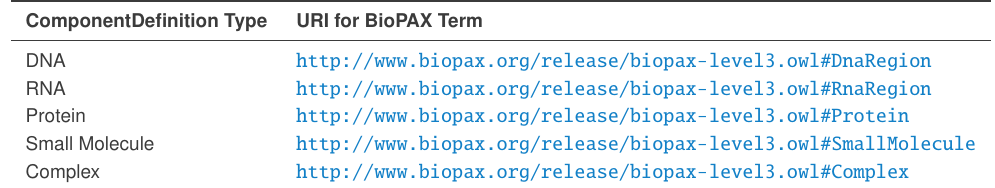
Table 2: BioPAX terms to specify the types property of a ComponentDefinition .